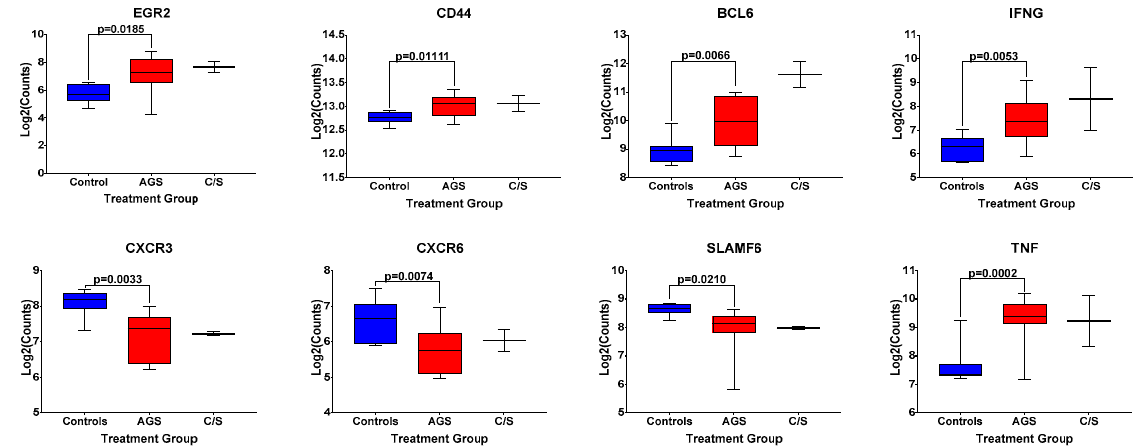
Figure 5. Normalized expression levels of select genes associated with iNKT cell development and effector function in bulk PBMCs from control, alpha-gal-sensitized but asymptomatic, and AGS subjects. p values were generated using an unpaired t test comparing AGS to controls, with p < 0.05 considered statistically significant. Due to the small sample size, the sensitized but asymptomatic group was excluded from statistical analysis.